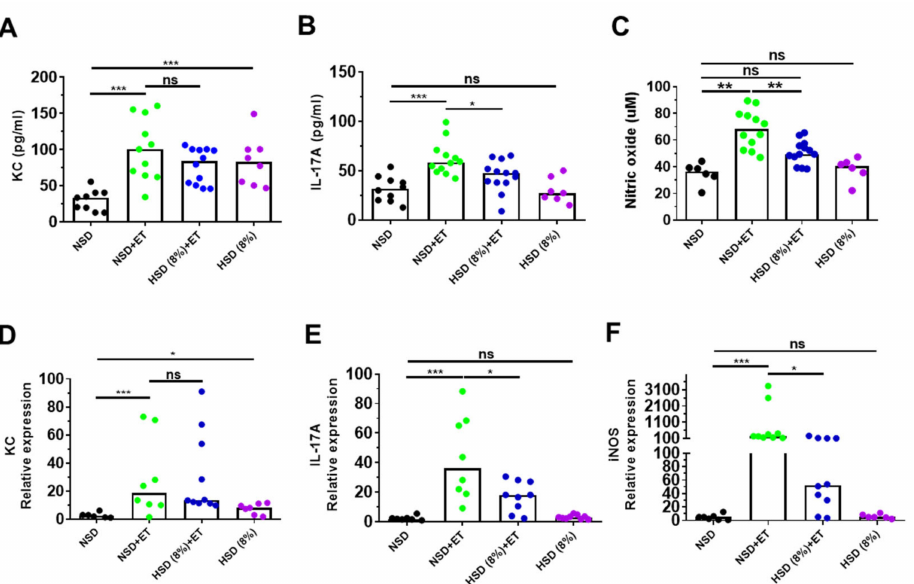
Figure 3. HSD decreases IL-17A and iNOS expression in the distal colon of ETBF-infected mice. C57BL / 6 female mice were inoculated with WT-ETBF (~1 × 10 9 CFU). HSD (4% and 8%) treated groups were given chow containing either 4% NaCl or 8% NaCl, respectively. C57BL / 6 mice were sacrificed at day 7 post-infection. Serum KC and IL-17A levels were examined by ELISA. Serum nitrite level was examined by nitric oxide assay. Distal colon was analyzed for the mRNA expression of IL-17A, KC, and iNOS by qRT-PCR. ( A ) Serum KC; ( B ) serum IL-17A; ( C ) serum nitrite; ( D ) KC expression; ( E ) IL-17A expression; ( F ) iNOS expression. In the scatter plots, each dot represents one mouse ( n = 6–13 mice per group). The horizontal bar denotes the median. * p < 0.05; ** p < 0.01; *** p < 0.001; ns, no statistical